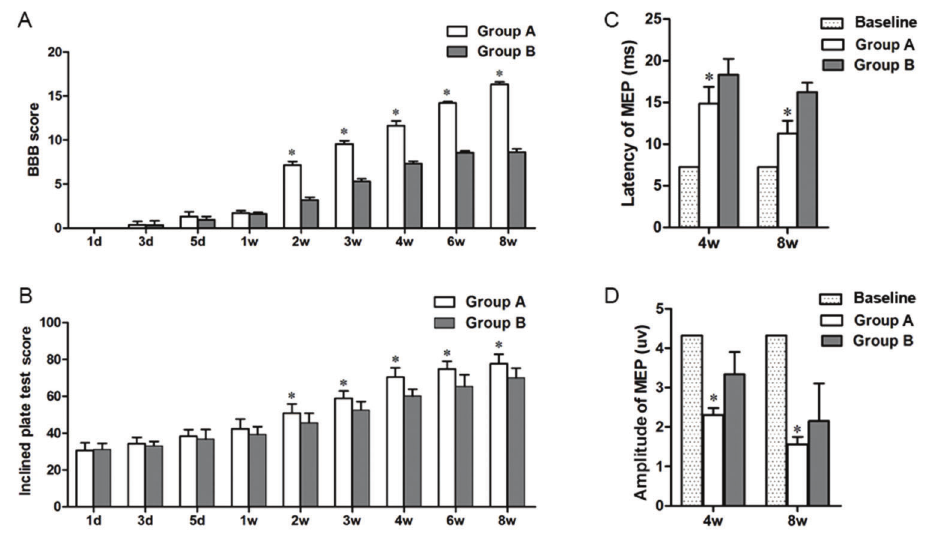
Figure 3. Evaluation of the functional recovery of the spinal cord in spinal cord injury rats between microglial cell transplantation group A and saline injection group B. A , Basso-Beattie-Bresnahan (BBB) score; B , Inclined plate test score; C , Latency of motor-evoked potentials (MEP); D , Amplitude of MEP. Data are reported as means ± SD. *P o 0.05 group A compared to group B ( t -test). d: day(s); w: